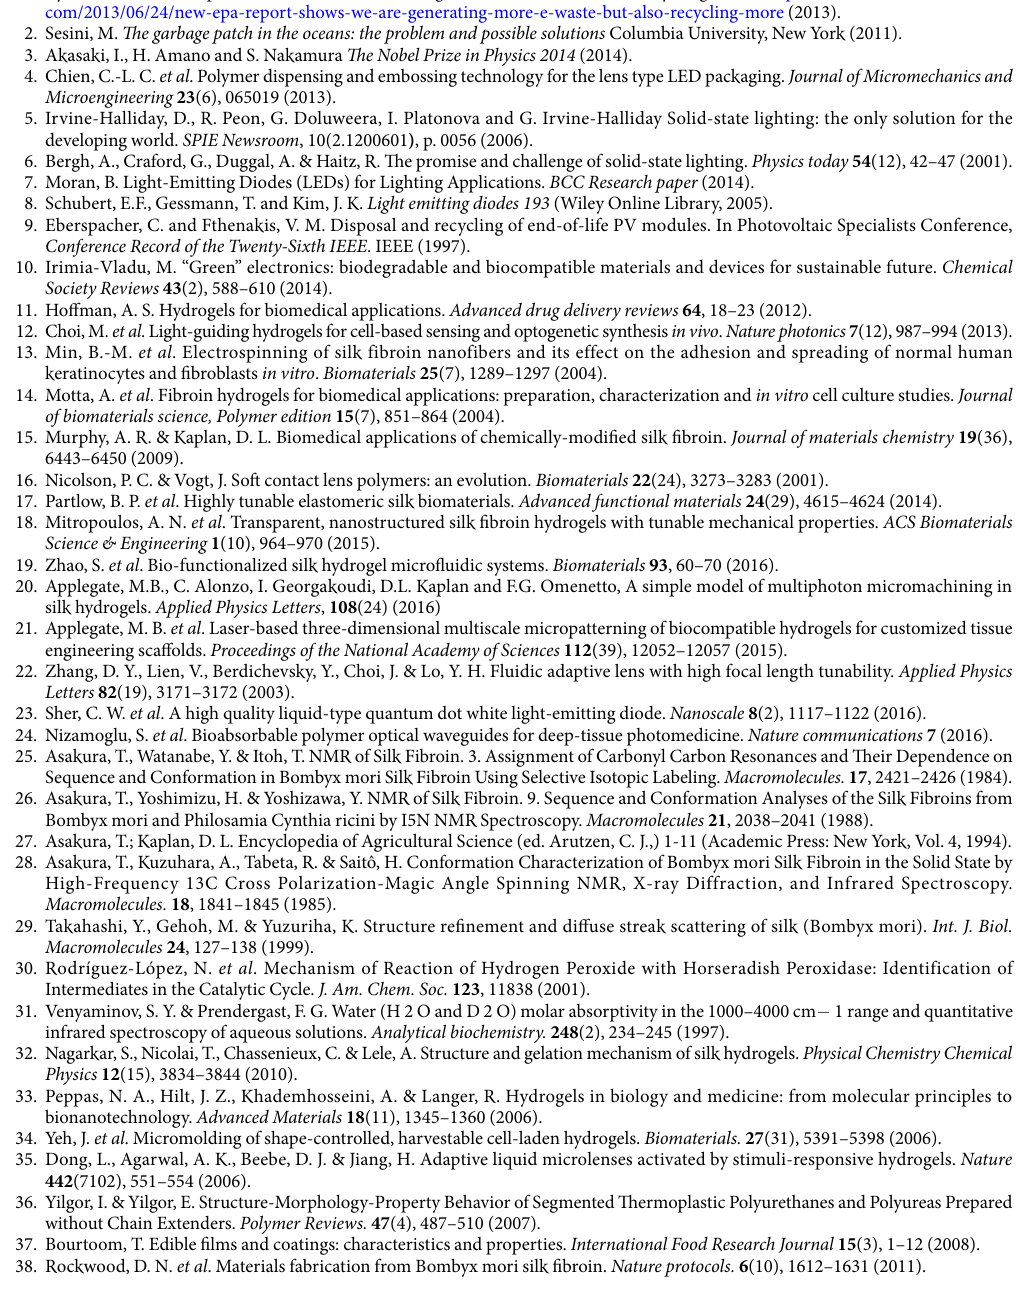
Using molds a silk hydrogel prepared and its weight was measured. For 2 days the decay in weight was measured. Afterwards, a silk hydrogel was prepared and a top layer of paraffin wax and poly(ester-urethane) was coated to increase its stability, and for 8 days the decay in weight was measured. Polymerization